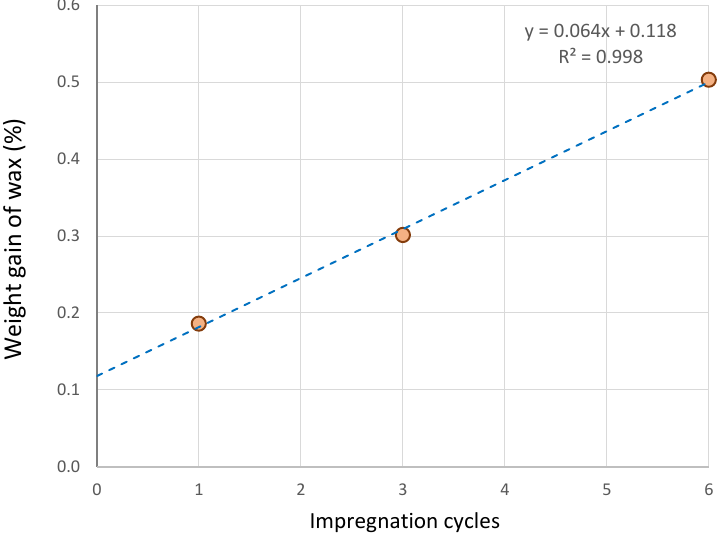
Figure 7. Weight gain after 1, 3 and 6 successive extraction/impregnation cycles with supercritical CO 2 without co-solvent.